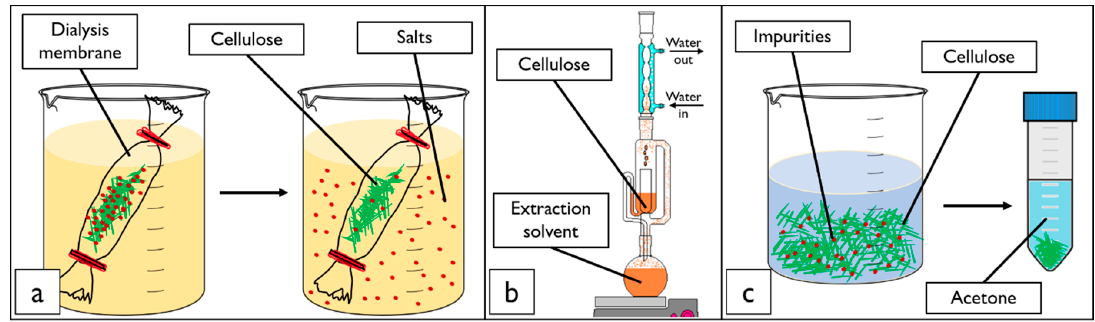
Figure 2. Schematics of post treatments on cellulose nanocrystals (CNCs)—( a ) dialysis, ( b ) Soxhlet extraction in a solvent, and ( c ) washing with